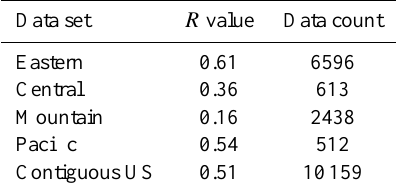
Table 4. Correlation coefficients and data counts for the hourly PM 2 . 5 /average AERONET AOD (0.67µm) collocation analy- sis (AERONET AOD averaged within the hour and 0.3 ◦ lati- tude/longitude of an hourly PM 2 . 5 measurement) for the eastern, central, mountain, and Pacific time zones and contiguous United States total for the 2-year (2008–2009) study period.